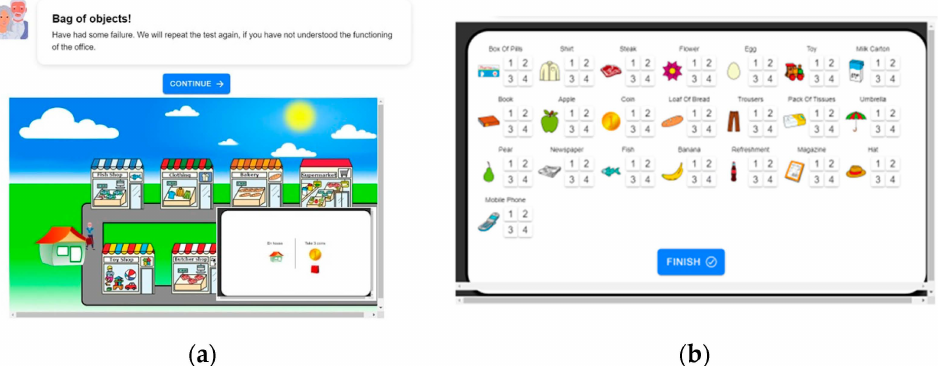
Figure 1. Example of exercise Gifts Purchase . It serves to improve planning skills (establishing goals, controlling implementation, and measuring results). The screen shows a shopping area, and the participant must buy a series of gifts for other people on account of each person’s listed preferences and within a limited budget. ( a ) is a screenshot of the main scenario, the stores that are in the city, along with an example of products that can be purchased in the sports store. ( b ) is an example of the people to buy a gift for and their tastes. Figure 2. Example of exercise Bag of Items . It serves to improve the working memory based on a simulated walk through a neighborhood, in which the participant exchanges relevant objects in various local places. The user must memorize the objects that the person picks up and leaves along the route (in each of the establishments that he visits) in order to be able to indicate at the end of the exercise the objects that remain in the bag. ( a ) is a screenshot of the main scenario: the stores of a city and the house of the avatar guiding the exercise, together with an example of the objects that the avatar takes from home (coins) and carries in the bag. ( b ) is an example of a panel in which the participant must select the objects left in the bag after the tour of the city and the quantity of each of